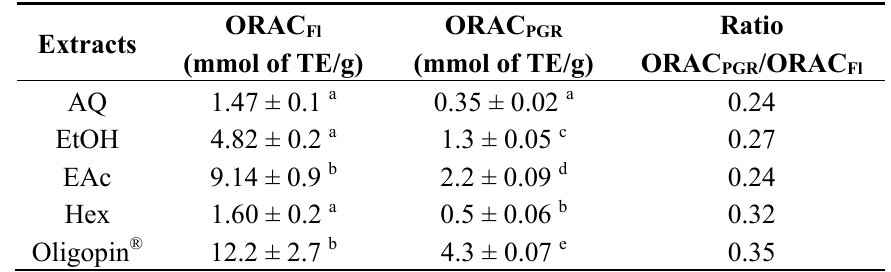
Table 2. ORAC PRG , ORAC Fl and ORAC PRG /ORAC Fl ratio values of M. arboreus extract and fraction.